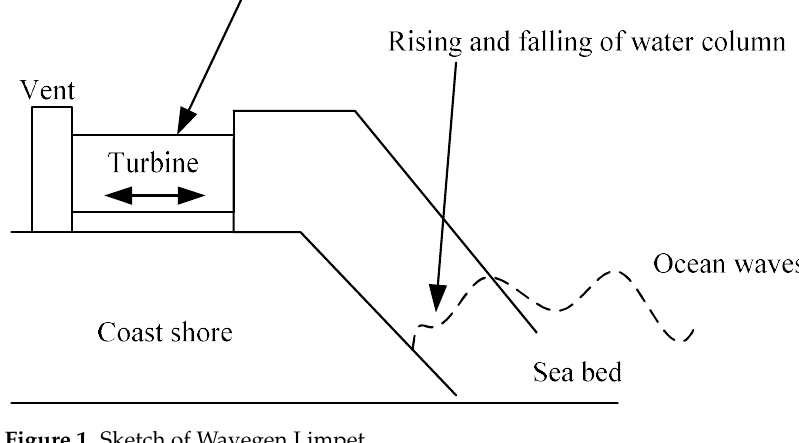
Figure 1. Sketch of Wavegen Limpet.